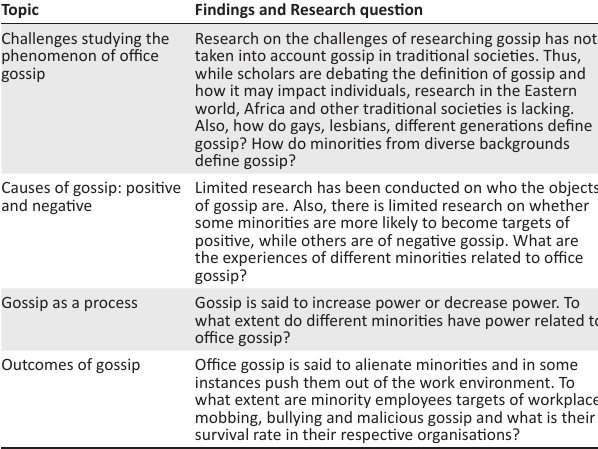
TABLE 2: Recommendations for future research on gossip related to